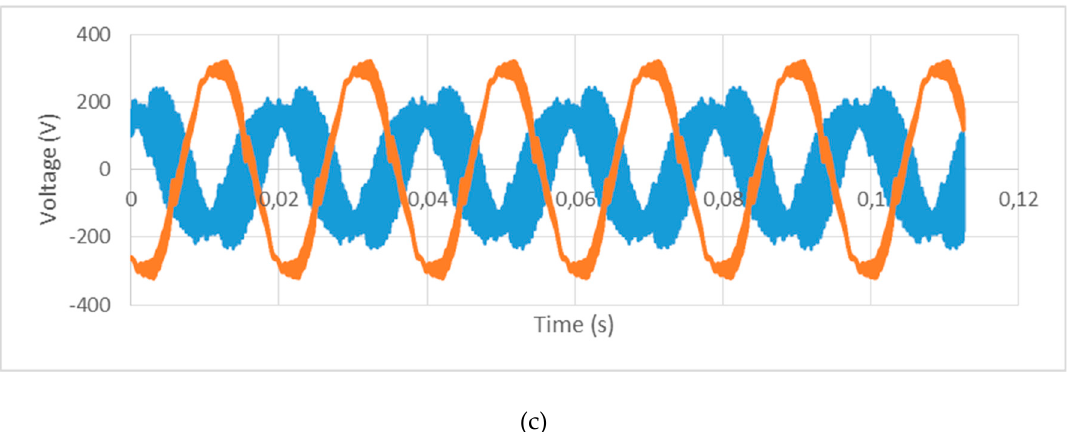
Figure 11. Waveform of the input phase voltage (orange) and output phase voltage (blue) for the referenced shift angle ψ = 60 ◦ ( a ); ψ = 6 − 0 ◦ ( b ) and ψ = 180 ◦ ( c ).